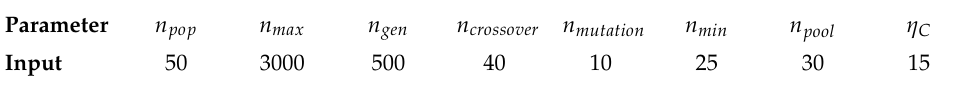
Table 7. Parameters of the Cumulative Multi-Niching Genetic Algorithm